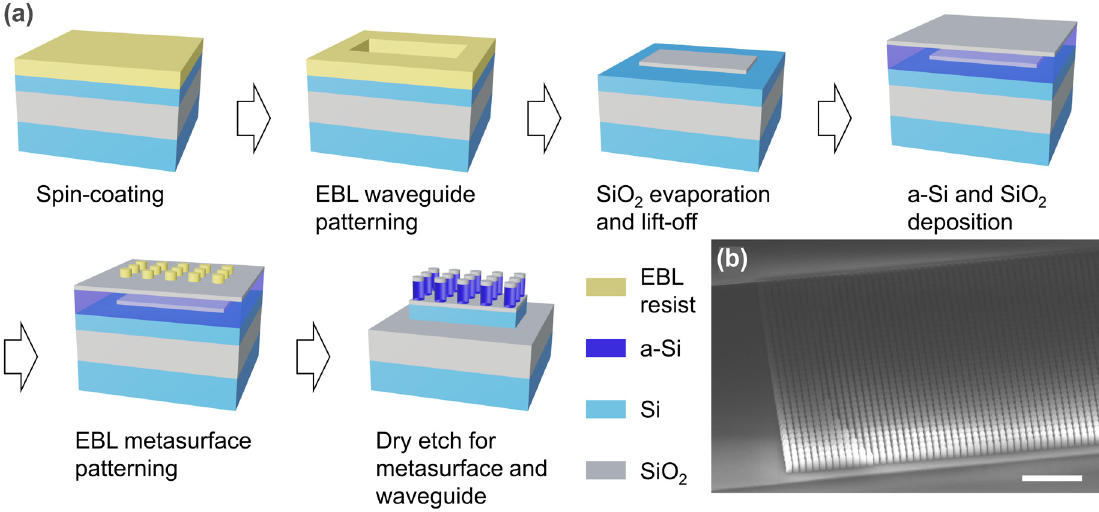
Figure 3: Fabrication processes and image of the devices. (a) Fabrication processes of the metasurface-on-waveguide structure using EBL and a single etching step. (b) Tilted SEM image of the metasurface monolithically integrated on a silicon waveguide. Scale bar: 5 μ m.